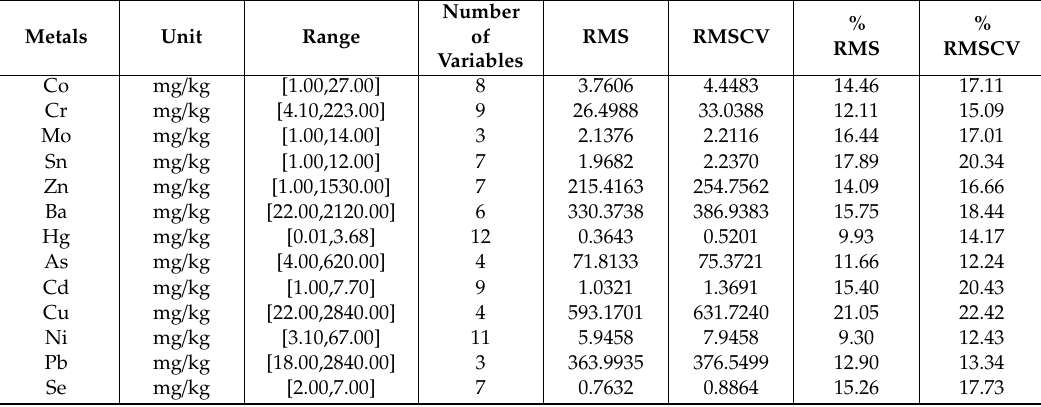
Table 2. The RMS and RMSCV values for the PLS model based on DRIFT data in the MIR.